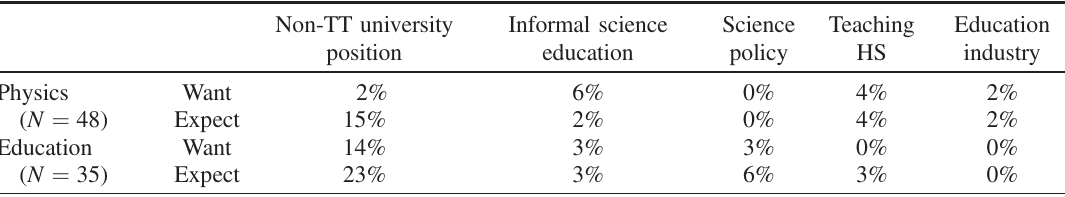
TABLE IV. “ Other ” professional wants and expectations for 10 years in the future (values are the percentage of the total